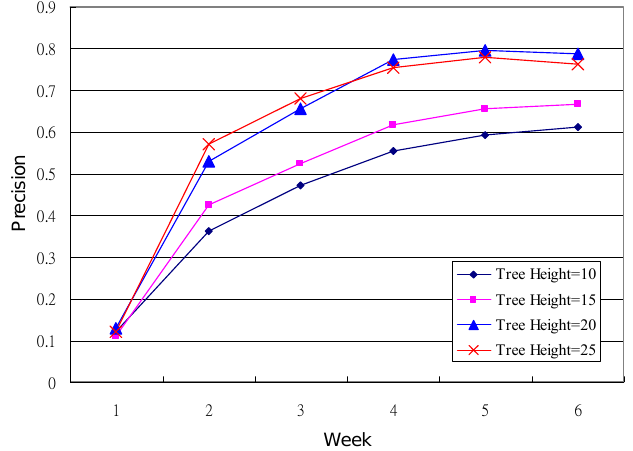
Figure 8. Experimental results for the refreshing music